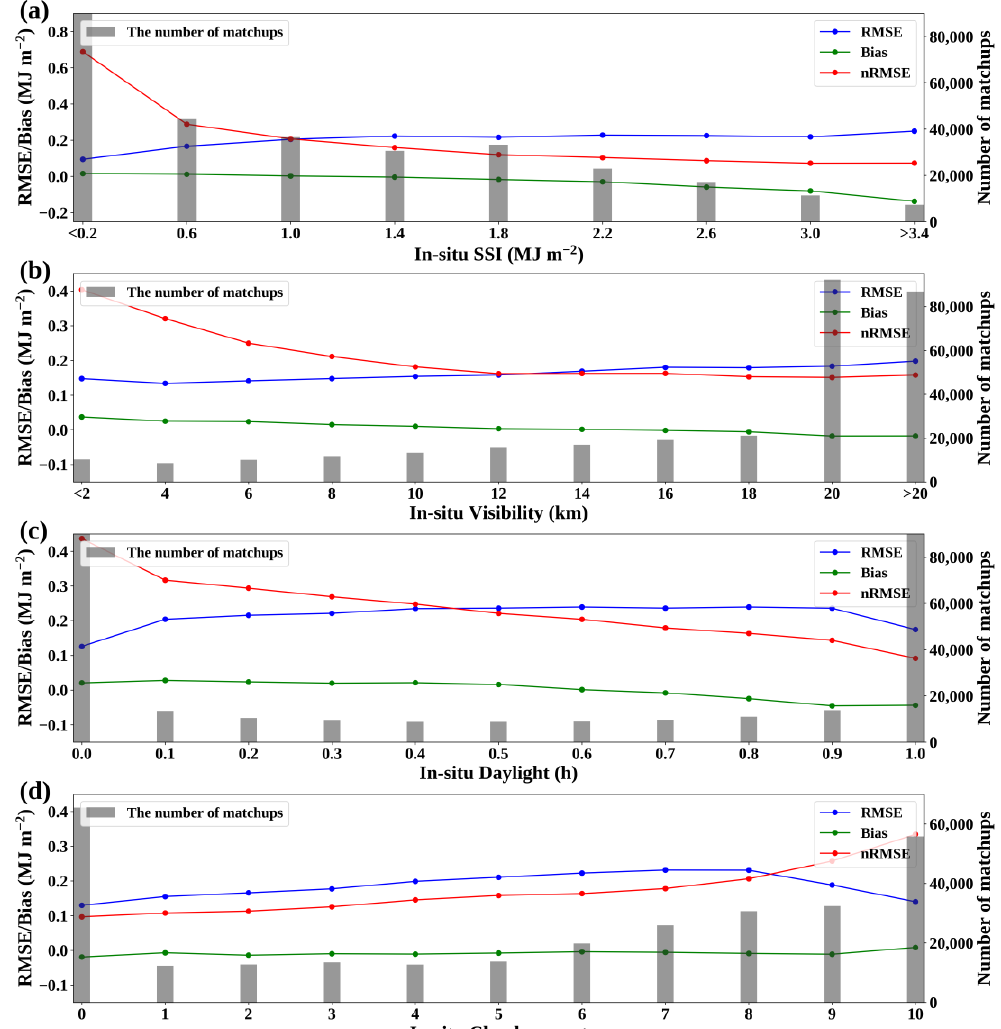
Figure 10. Variation of accuracy by comparison between GK2A/AMI-derived SSI estimates using the CNN model as the reference model and in situ SSI from ASOS stations operated by KMA with respect to ( a ) in situ SSI, ( b ) in situ visibility, ( c ) in situ daylight, and ( d ) in situ cloud amount; the blue, green, and red lines represent RMSE, bias, and nRMSE, respectively, and the gray bars denote the number of matchups.